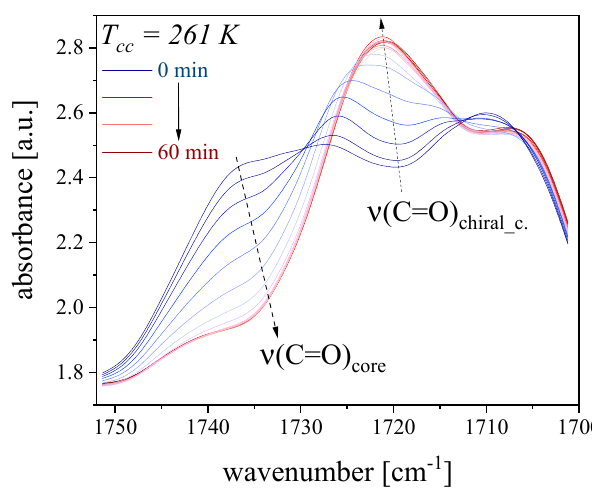
Figure 14. Temporal changes of FTIR spectra in the region of ν (C = O) core and ν (C = O) chiral_c. vibrations during cold crystallization at 261 K.